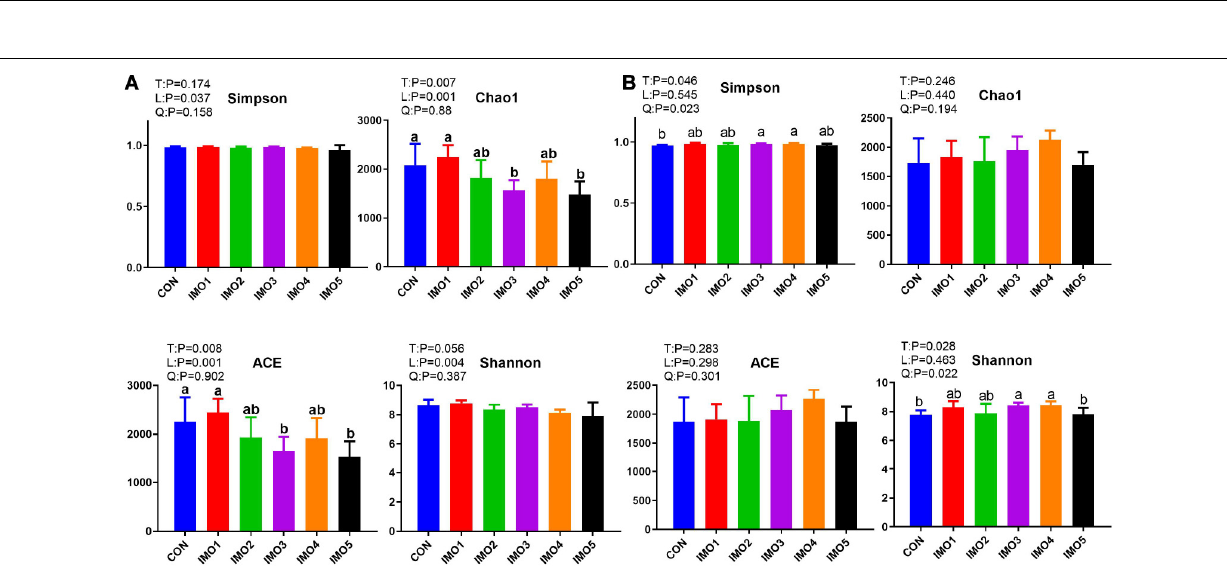
Frontiers in Microbiology |